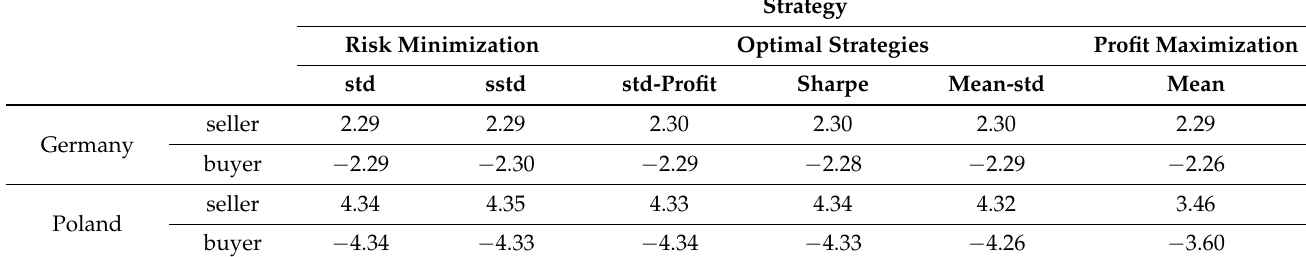
Table 5. The average price of a seller as well as a buyer per unit of risk, measured by a standard deviation. The buyer’s prices are negative to denoted the outflow, while the seller’s positive to denote the inflow. Strategy Risk Minimization Optimal Strategies Profit Maximization std sstd std-Profit Sharpe Mean-std Mean